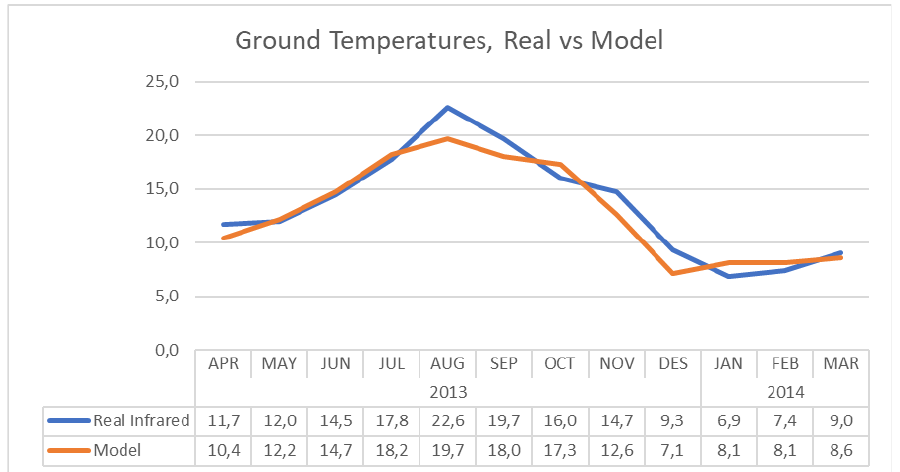
Figure 11. Ground temperatures, real vs. model.